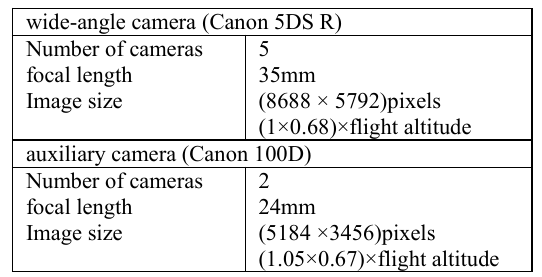
Table 1. Technical specifications of the imaging module The wide-angle camera for tethered balloon has two advantages.